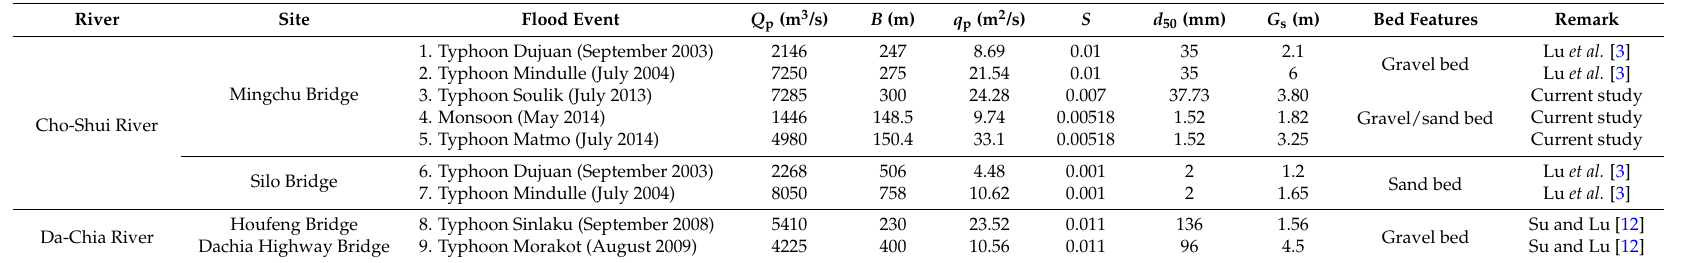
Table 1. Field data collection for short-term general scour induced by